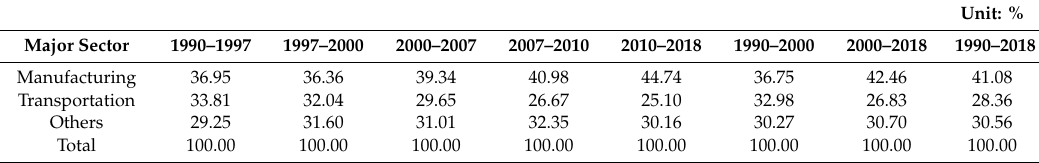
Table 5. Percentage share of CO 2 emissions by major economic sector, 1990–2018.